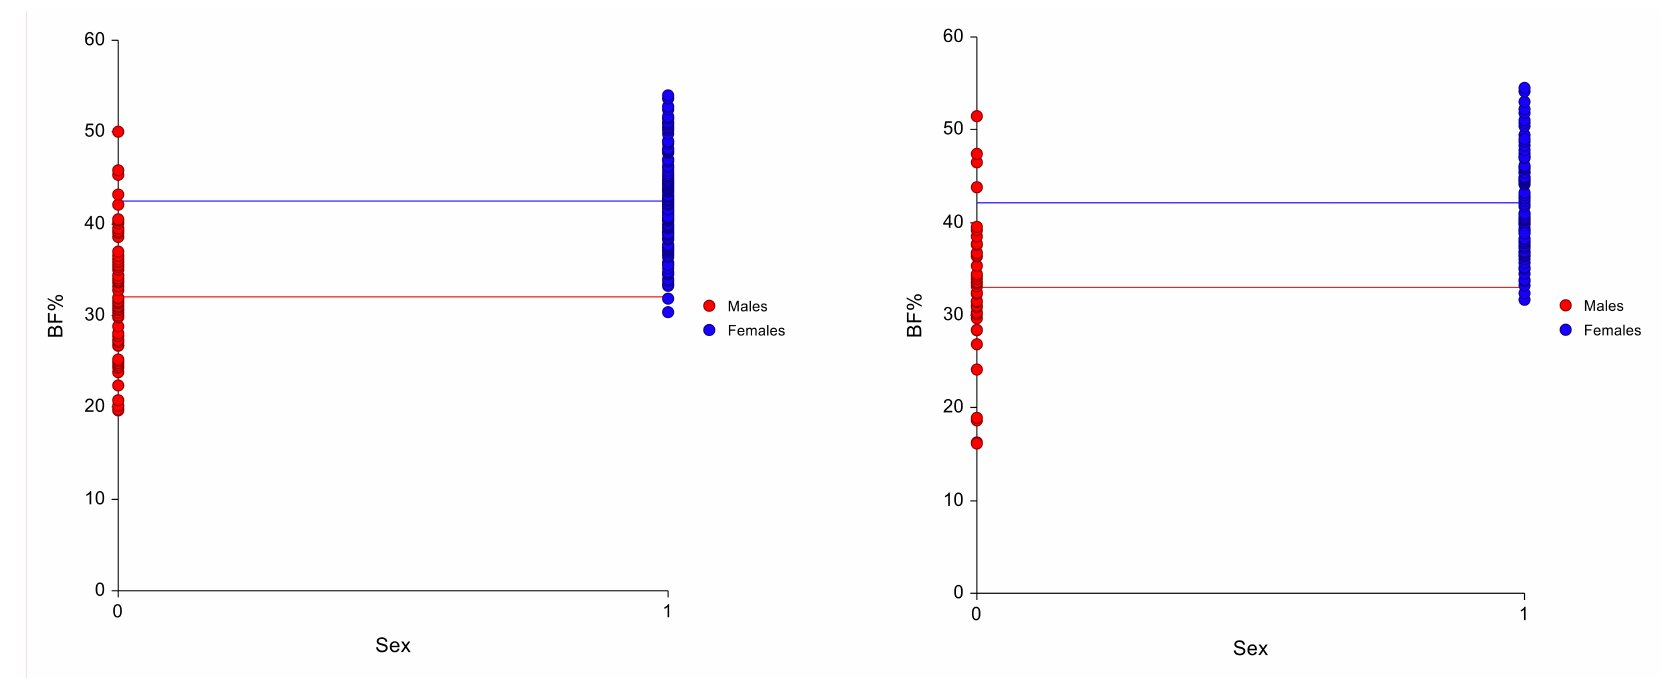
Figure 1. Scatter plots showing correlation between BF% and predictors in the ( a ) training sample ( n = 238) and ( b ) validation ( n = 137)